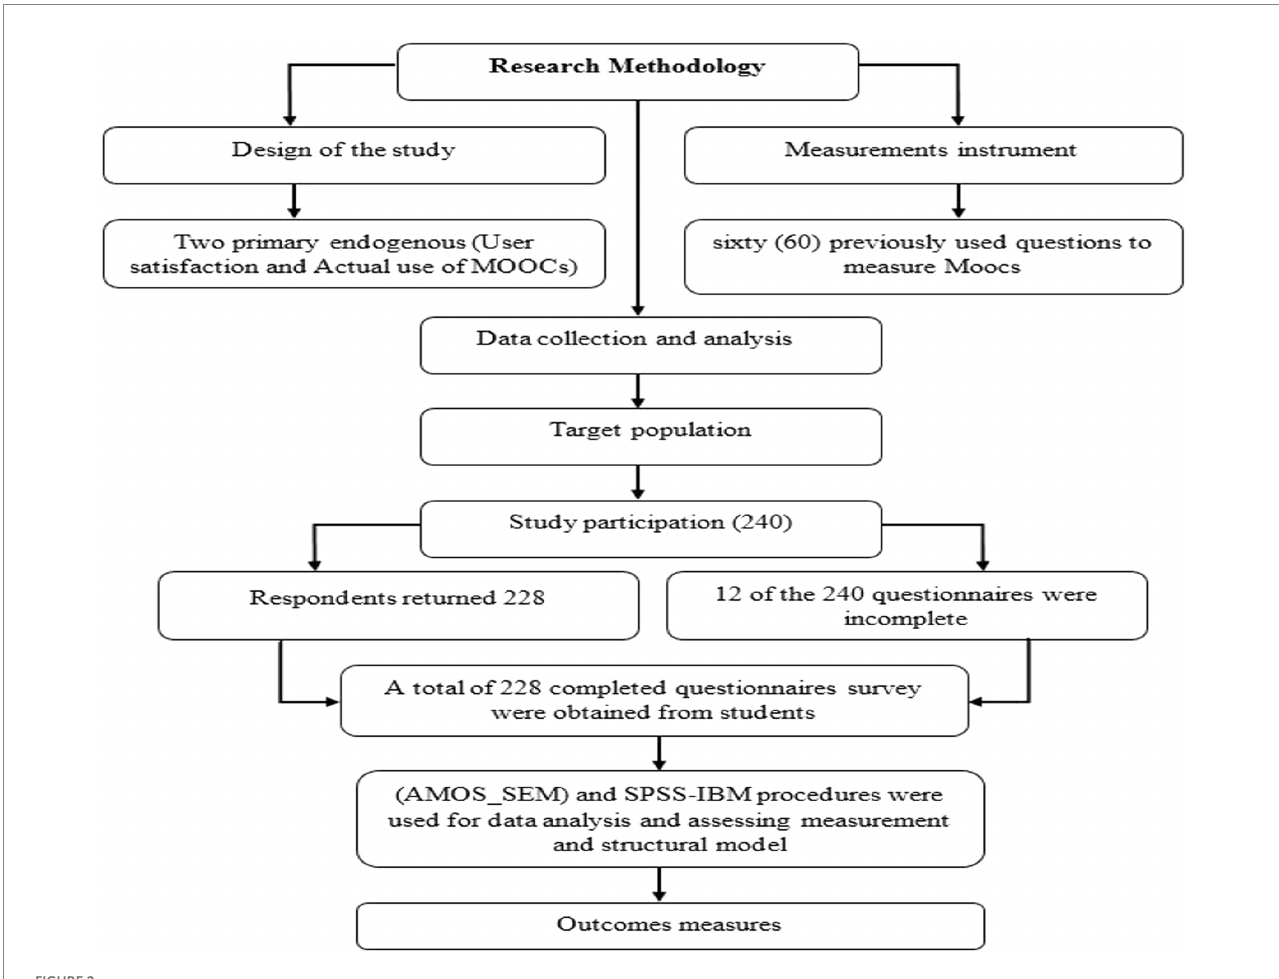
FIGURE 2 Diagram for methods and